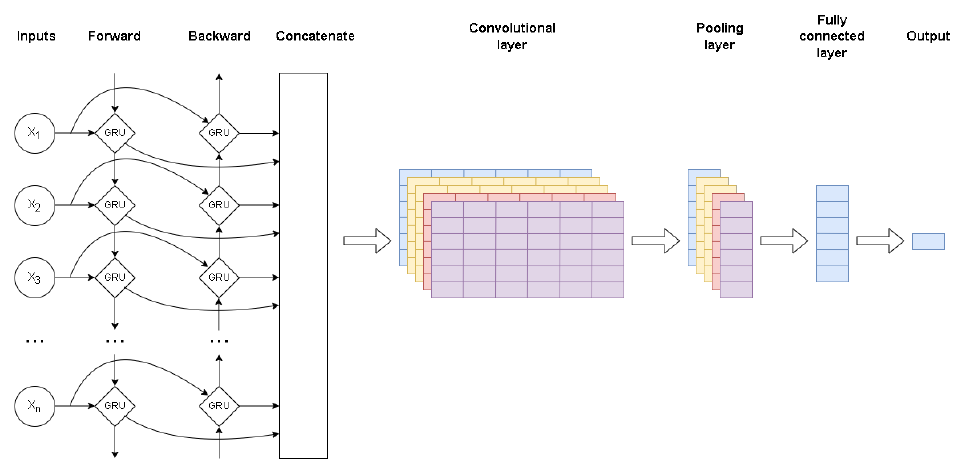
Figure 4. Flowchart of the proposed